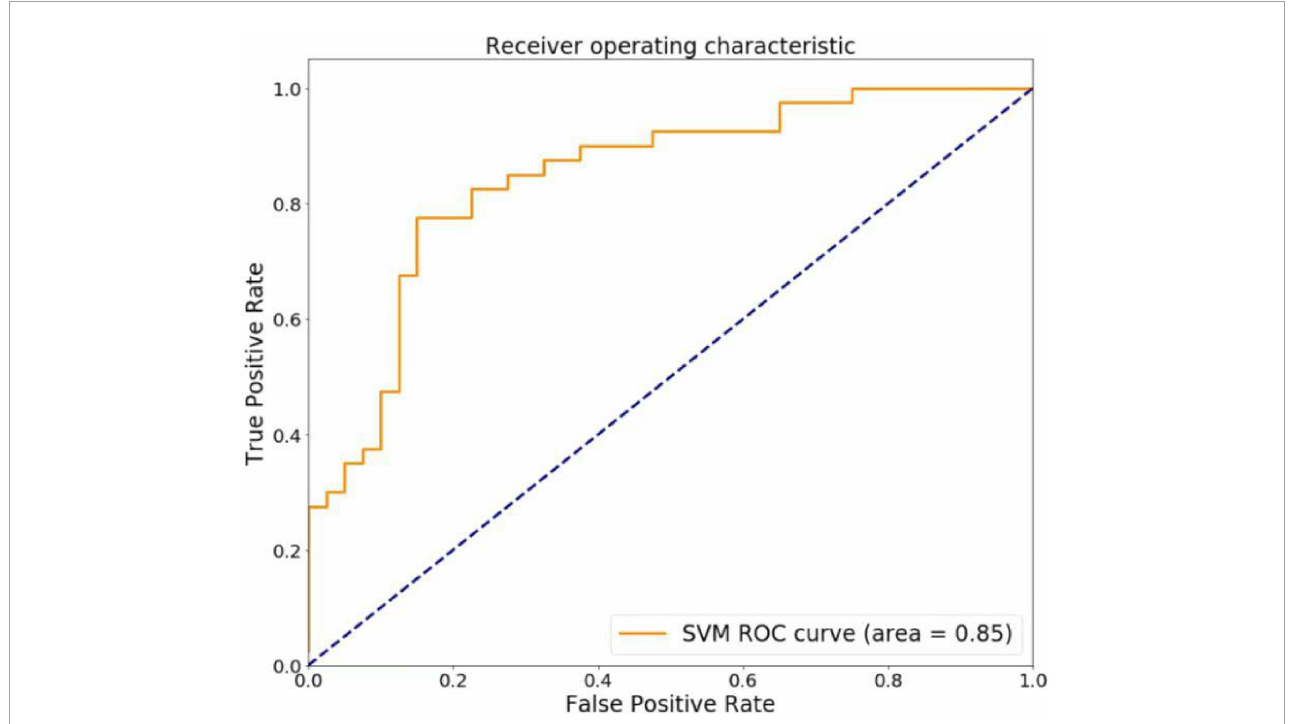
FIGURE5 The regions of interest (ROC) curve of support vector machine (SVM) model. The SVM model showed good performance for the classification prediction of PACG, with an AUC of